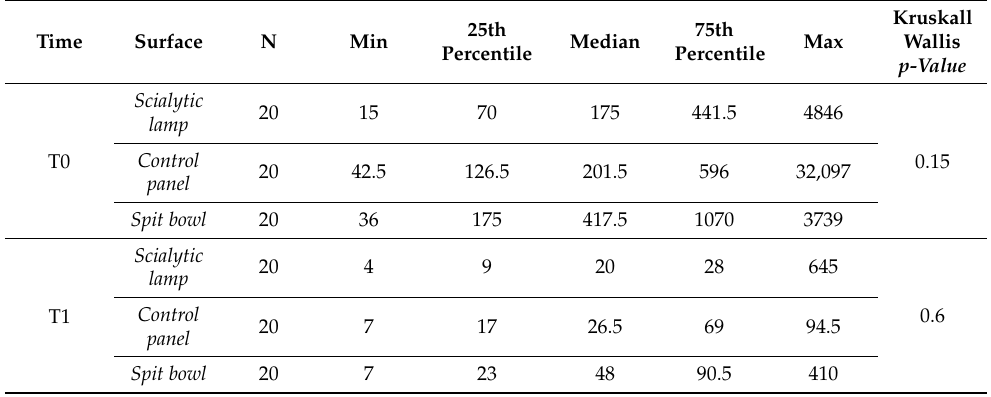
Table 5. Distributions of the RLU values for each evaluated surface at T0 and T1; ( p < 0.05). A cut-off of 150 RLU was set to consider a surface clean.